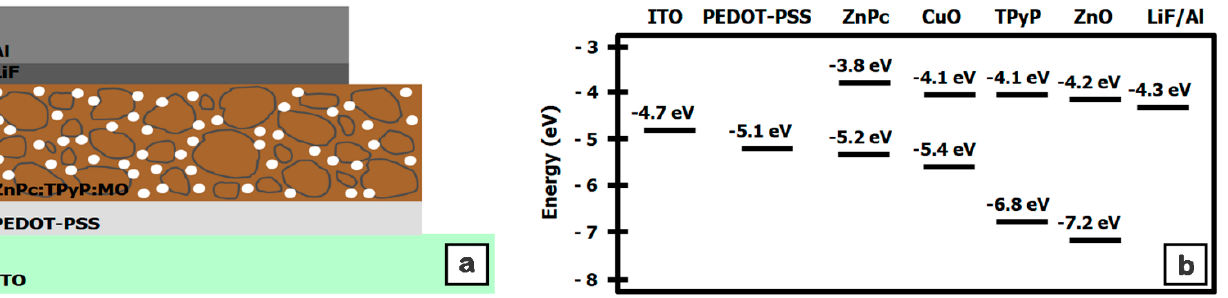
Figure 9. Schematic representation of the structure based on macrocyclic compounds:metal oxide (MO) particles nanocomposite thin films ( a ) and the energy levels diagram of the structure components ( b ).